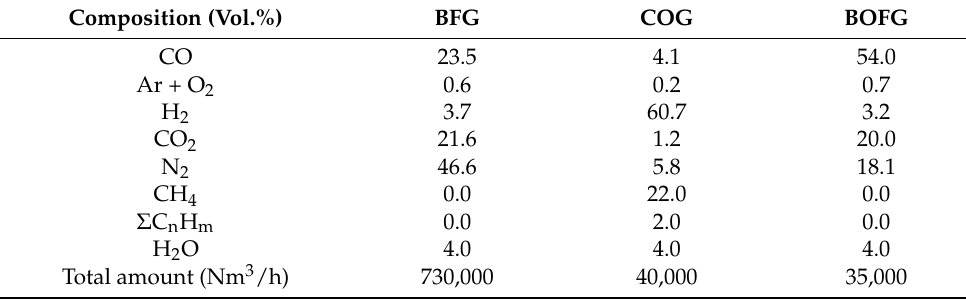
Table 2. Mean composition of steelworks off-gases (data from